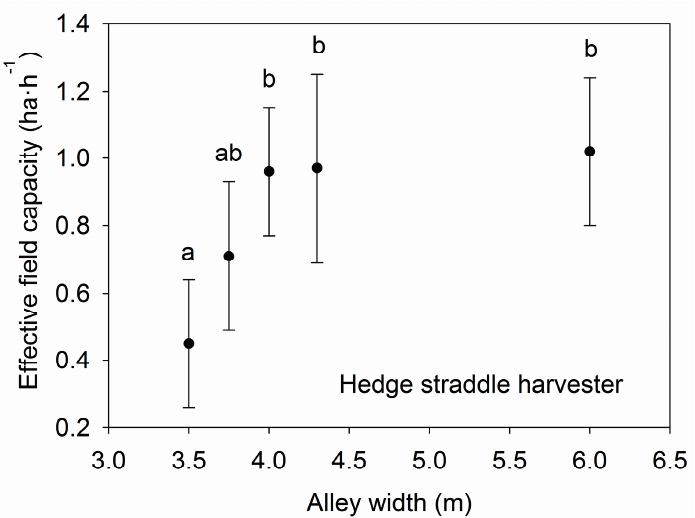
Figure 5. Effective field capacity and row alley width relationship. Different letters indicate significant differences ( p < 0.05) according to Scheffé’s